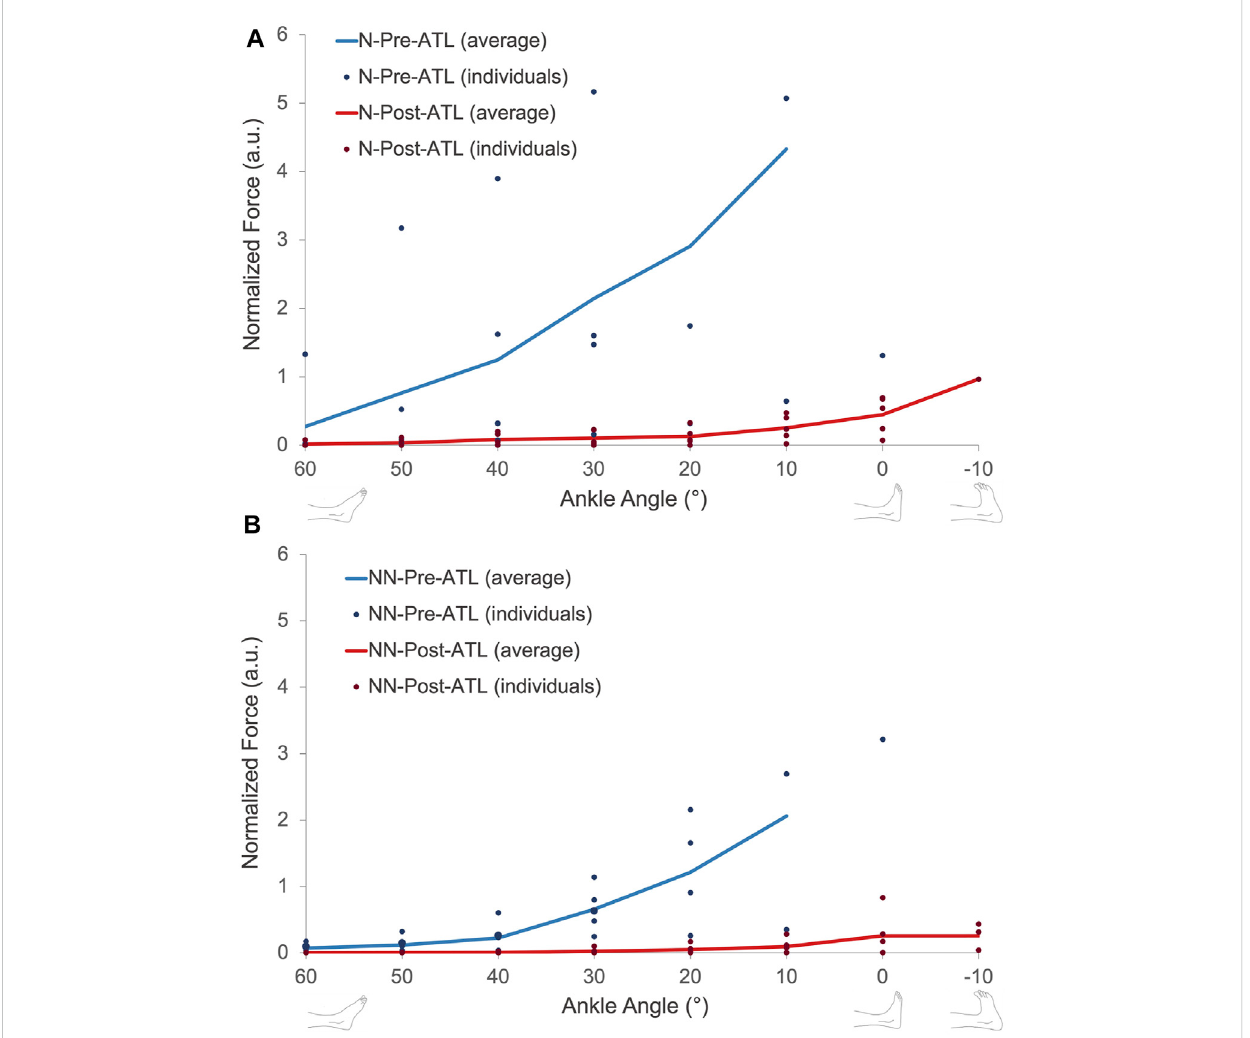
FIGURE 5 Normalizedpassiveforce-ankleanglecharacteristicsofpatientswith (A) andwithout (B) neurologicalconditionspre-andpost-ATL. N=neurologic patient, NN = non-neurological